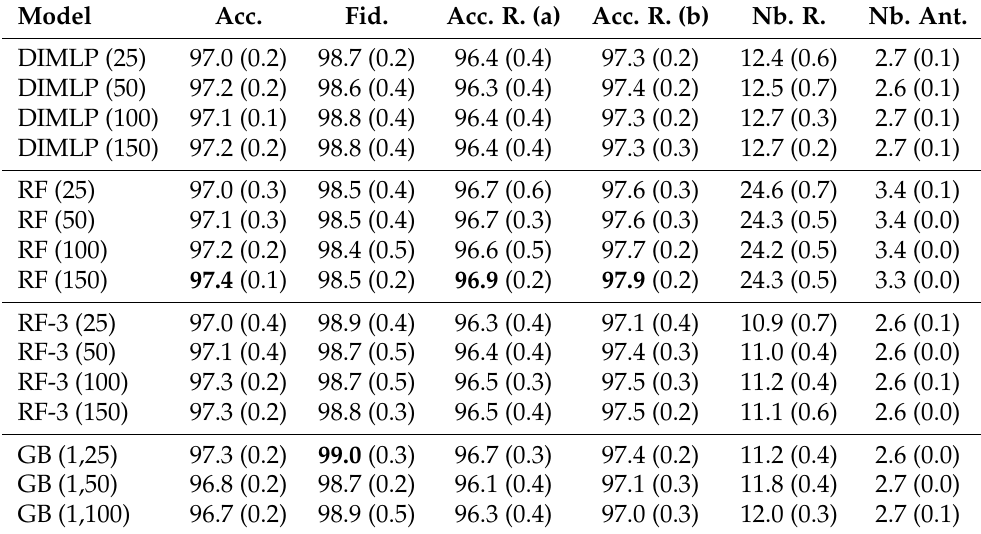
Table 3. Average results obtained on the “Breast Cancer” dataset. For each column, the highest average accuracy or average fidelity is represented in bold, along with the lowest average number of rules or average number of